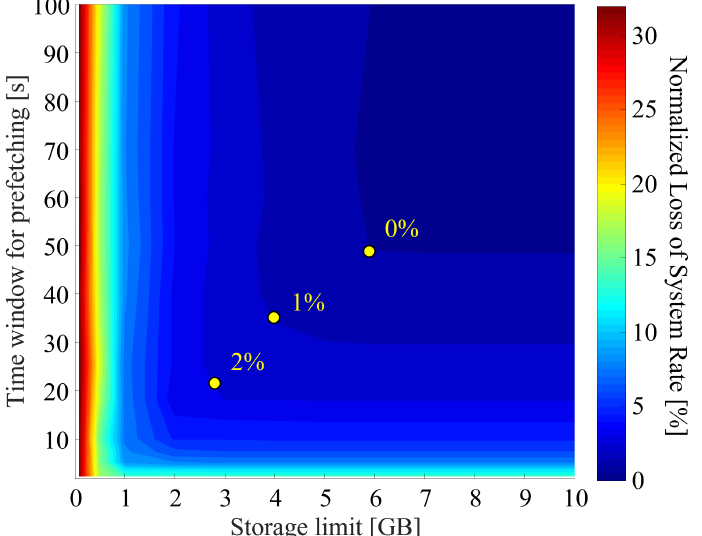
Figure 11. Normalized loss of the system rate (1 Gbps backhaul capacity, 60 GHz access, and WPF with 200